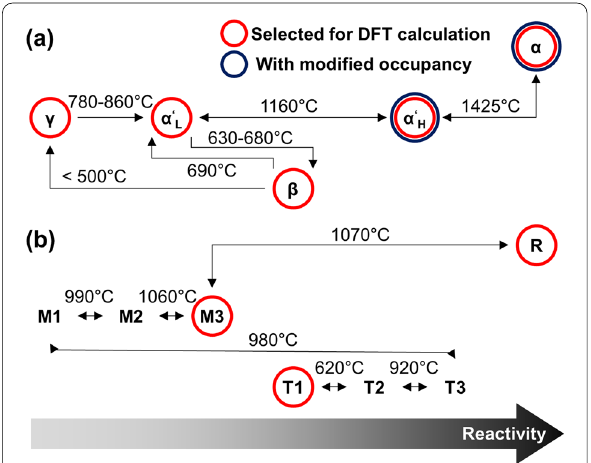
Fig. 1 High-temperature phase transition among a belite and b alite